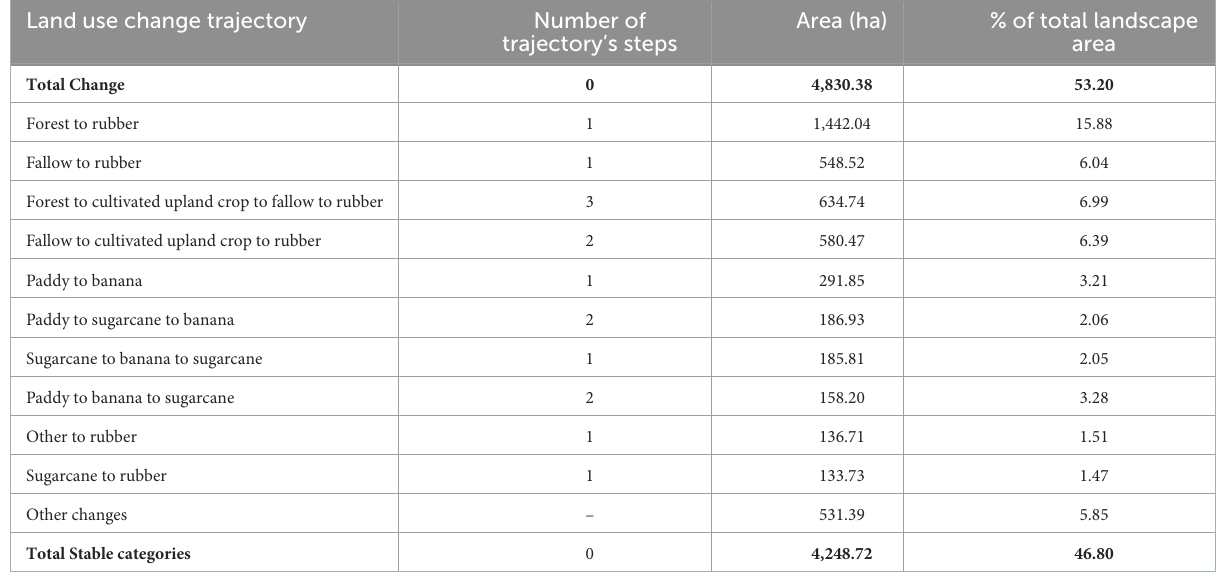
TABLE 4 Land use change trajectories, frequency of changes, and areas that remained stable between 2000 and 2017 in the case study landscapes. Land use change